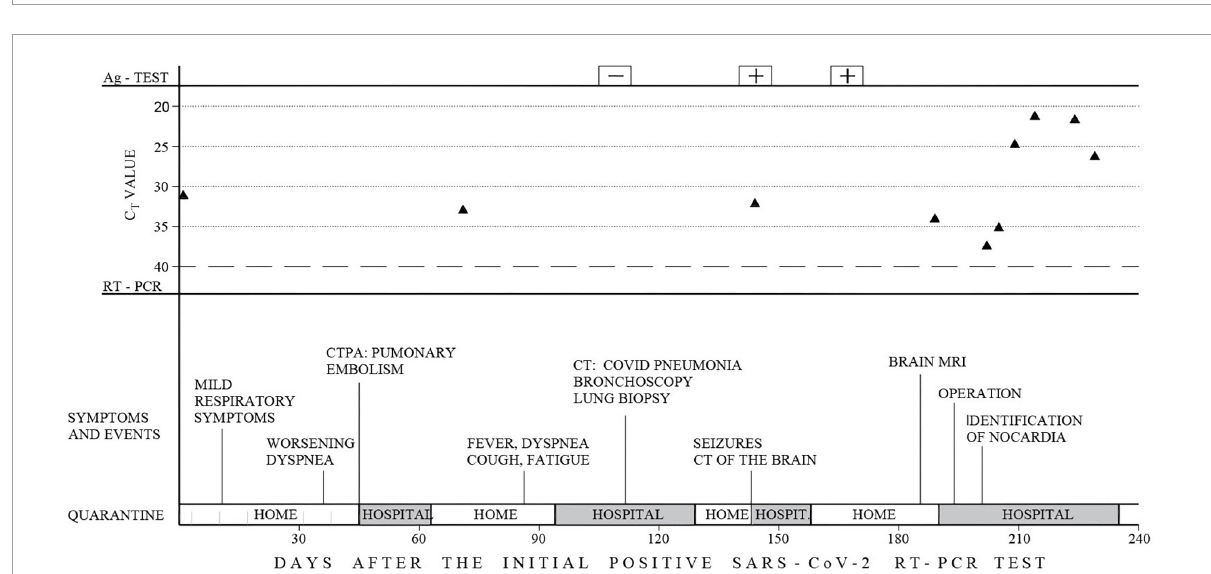
FIGURE3 Timeline of the clinical course. Timelines of hospital admissions, symptoms, events and SARS-CoV-2 testing are labeled from the initial positive RT-PCR test. The Novel Coronavirus (2019-nCoV) Nucleic Acid Diagnostic Kit (PCR-Fluorescence Probing) for the qualitative detection of the ORF1ab and N genes of SARS-CoV-2 RNA was used with Ct value ≤ 40 considered a positive